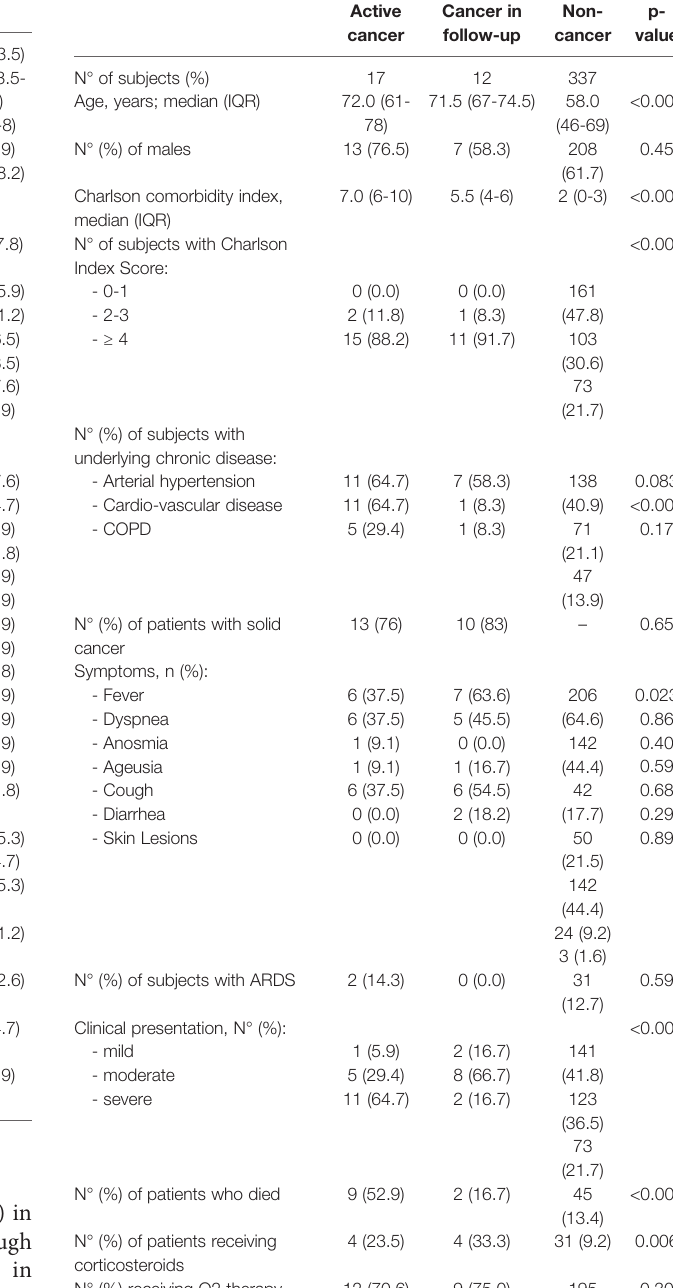
Active Cancer in cancer